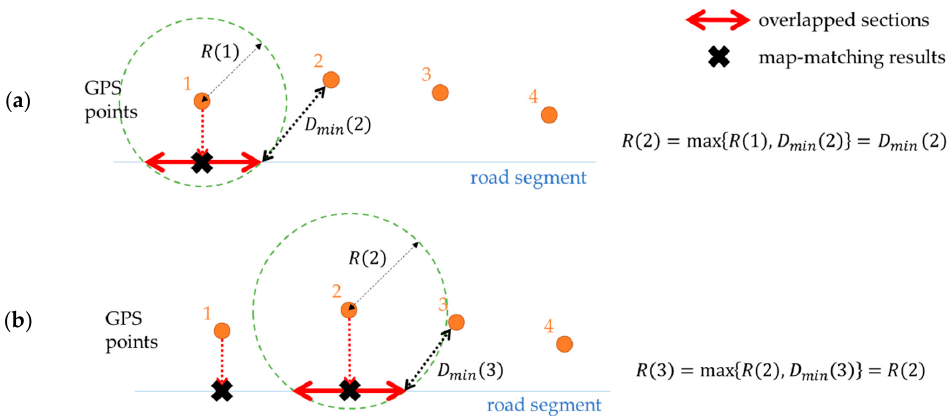
Figure 6. Determining search radii and relocating GPS points: ( a ) Search radius for the 2nd point is (cid:1830) (cid:3040)(cid:3036)(cid:3041) (cid:4666)2(cid:4667) because (cid:1844)(cid:4666)1(cid:4667) (cid:3407) (cid:1830) (cid:3040)(cid:3036)(cid:3041) (cid:4666)2(cid:4667) ; ( b ) search radius for the 3rd point is (cid:1844)(cid:4666)2(cid:4667) because (cid:1844)(cid:4666)2(cid:4667) (cid:3408) (cid:1830) (cid:3040)(cid:3036)(cid:3041) (cid:4666)3(cid:4667) . Map-matching results are identified to the geometric centers of the overlapped sections.